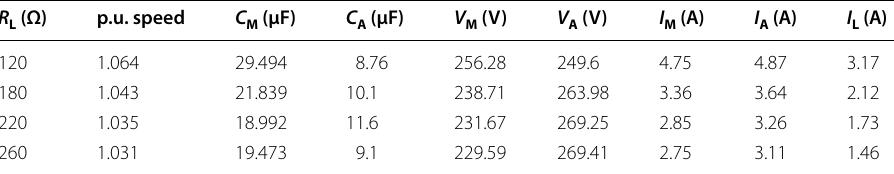
Table 2 Dynamic responses of the proposed connection of the TWSPSEIG at resistive loads R L (Ω) p.u. speed